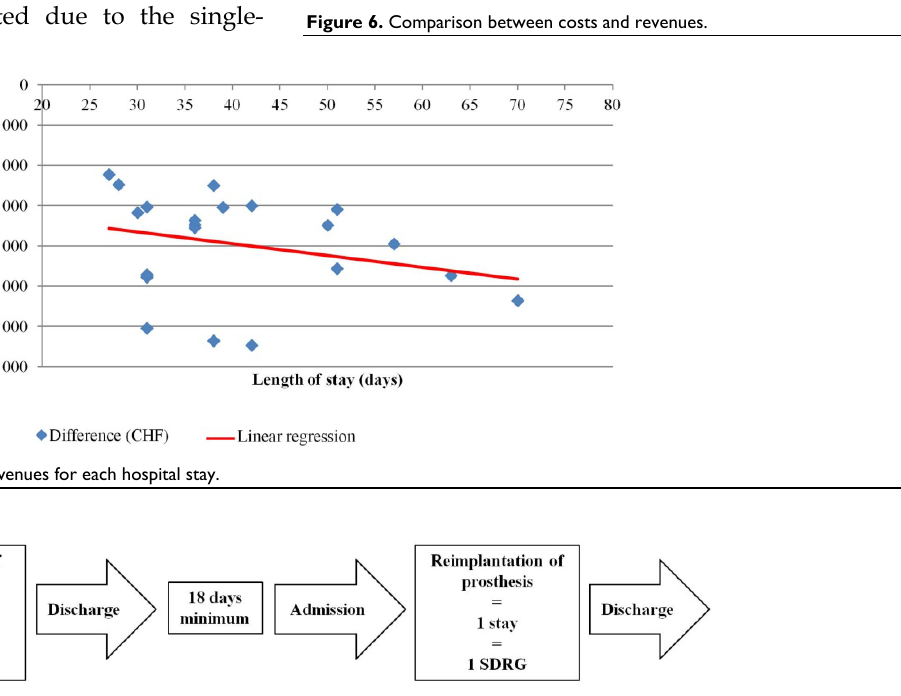
Figure 8. SDRG system for